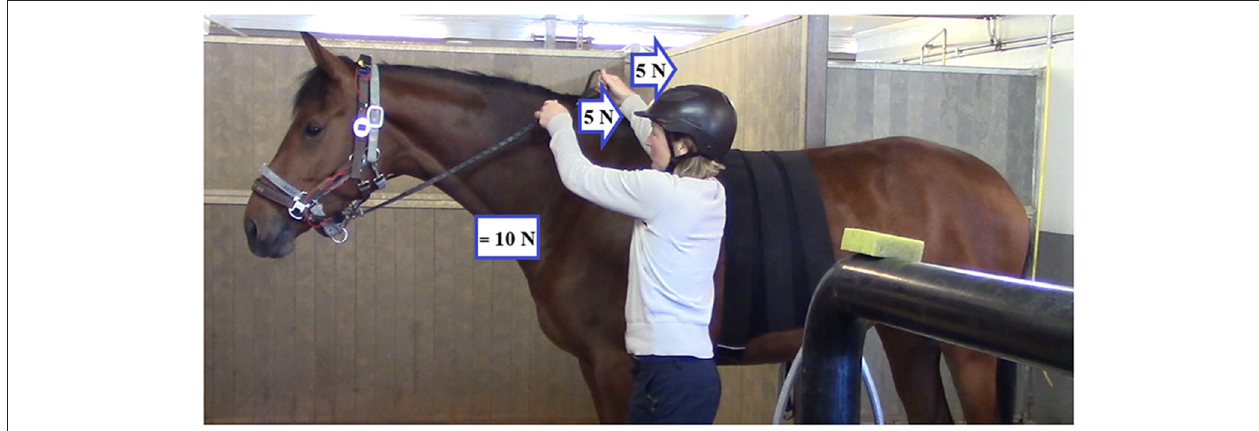
FIGURE 1 | Position of the handler during the treatments. To determine the resultant force to which the horse’s nose or mouth was subjected, left and right rein tension values were added. Rein tension values indicated in the figure are only examples.